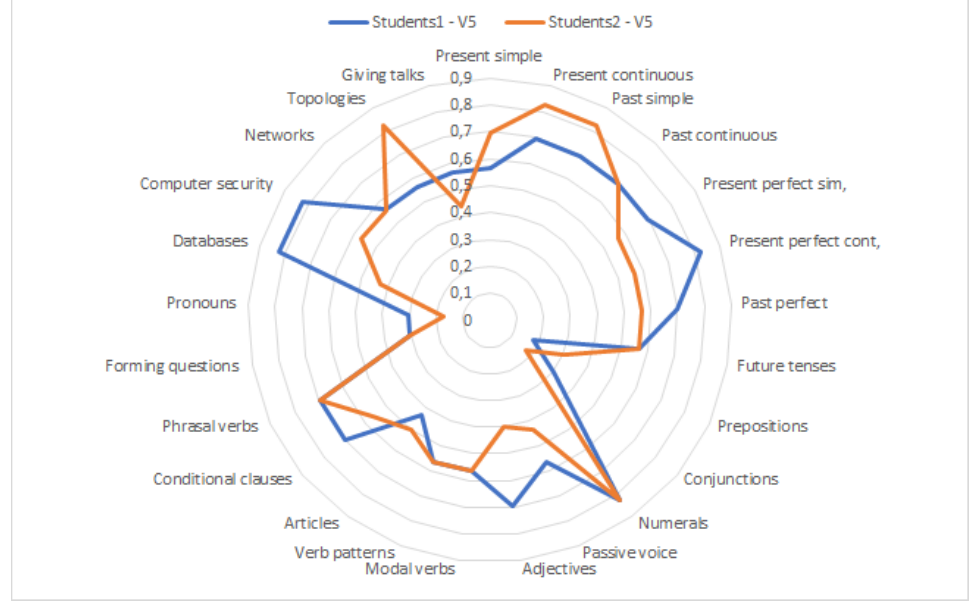
Figure 14. A graph showing students’ V5 assessment with subsequent impact on their personal study paths.